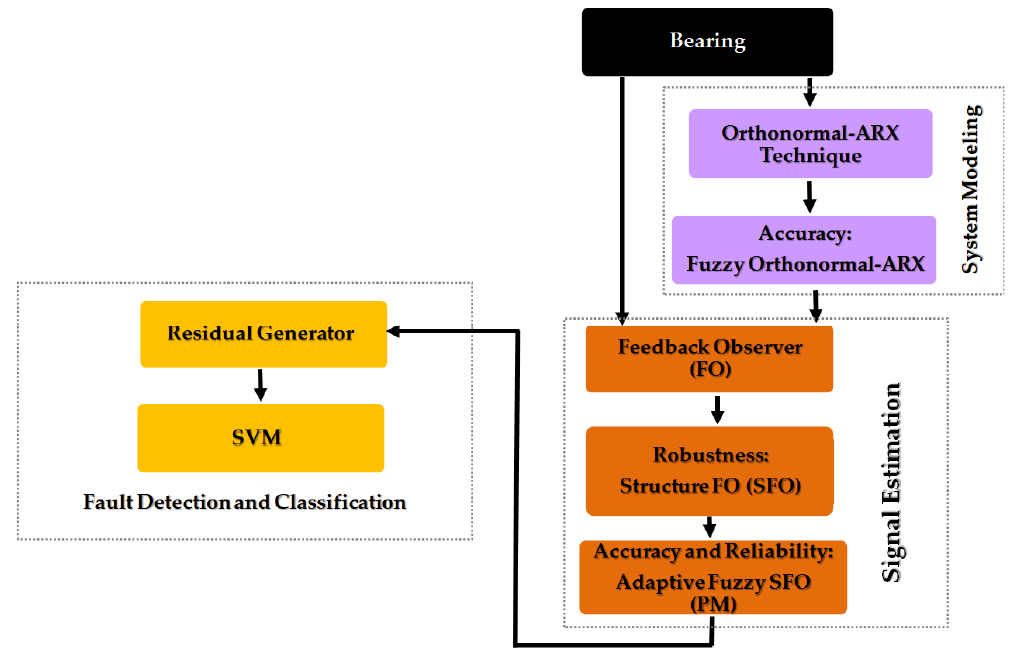
Figure 1. Proposed hybrid bearing fault diagnosis approach.